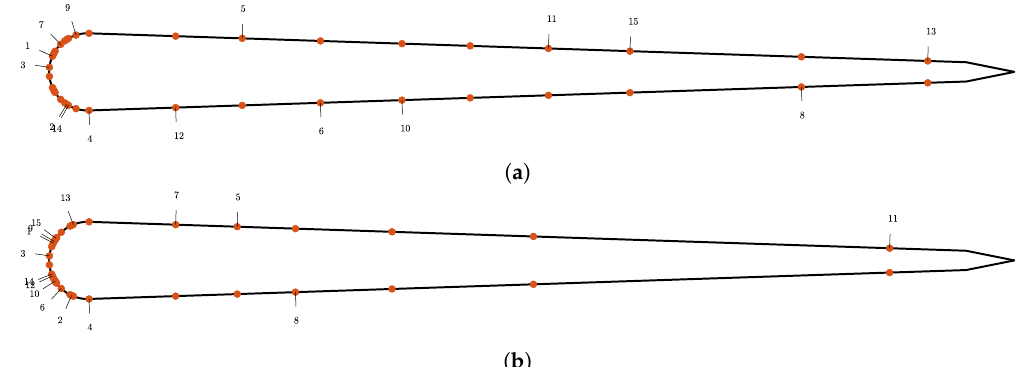
Figure 9. Optimal sensor locations for the shear stress measurements for the “size of the leading school” in ( a ) experiment and “relative position” experiment in ( b